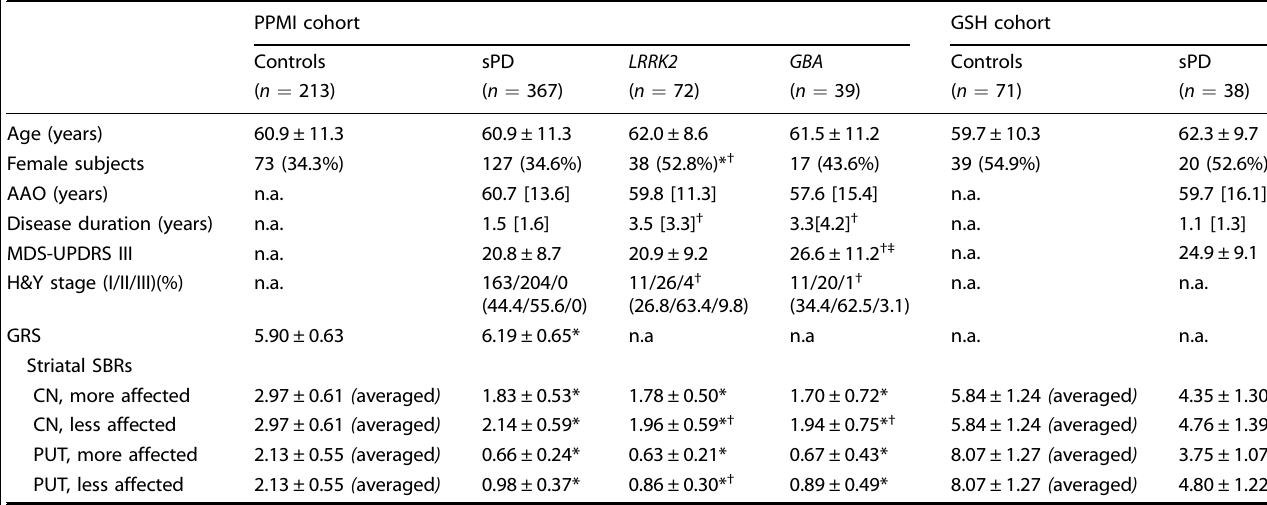
Table 1. Demographics and characteristics of the